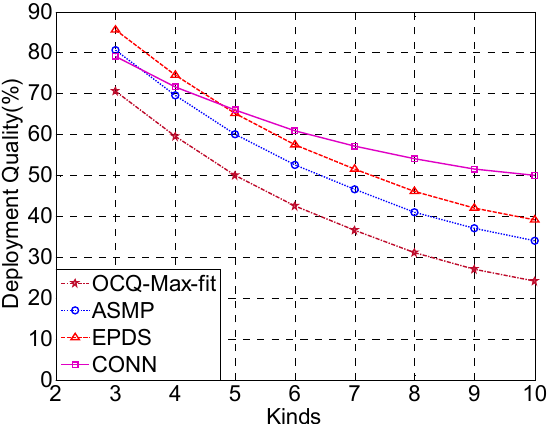
Figure 7. The CONN algorithm is compared with the ASMP, EPDS and OCQ-Max-fit algorithms in terms of the deployment quality with diverse kinds of sensors.